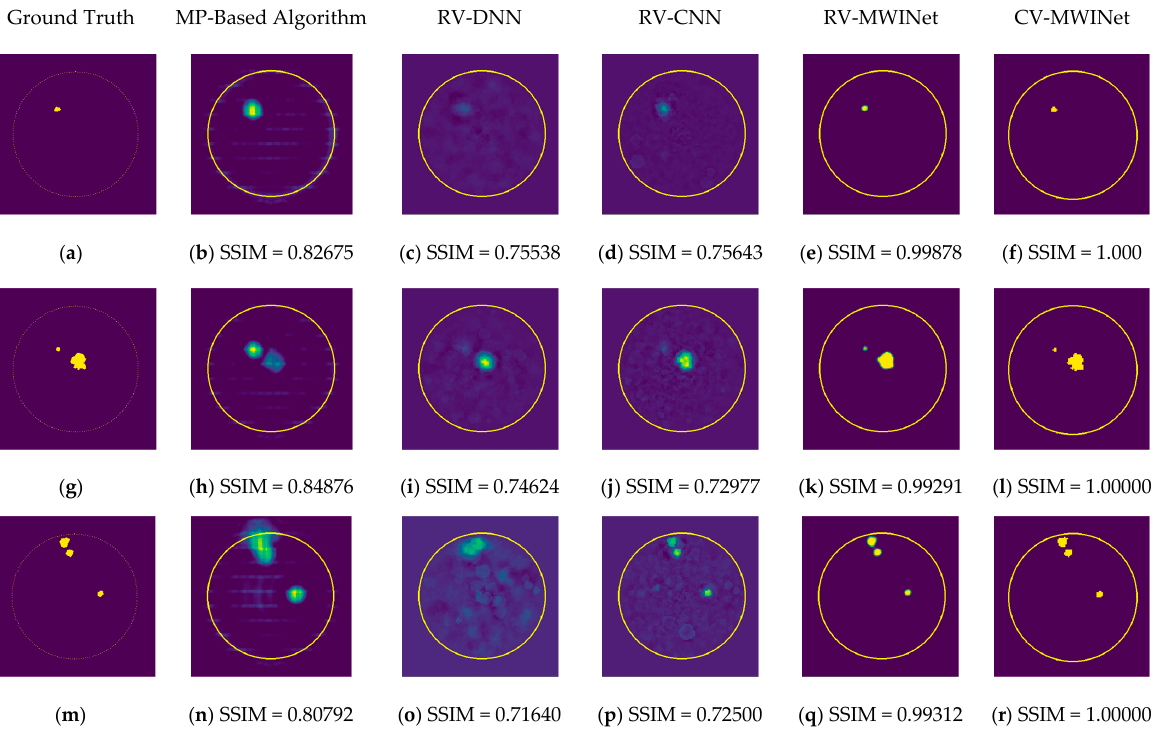
Figure 11. Comparison of samples of microwave images generated by the proposed neurocomputa- tional models for train data (( a , g , m ) are ground truth images). Figure 11b,h,n depict radar-based images generated by the MP-based method for